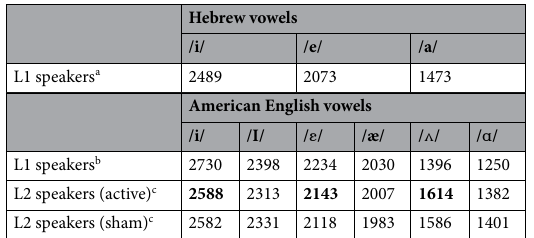
Table 2. Mean F2 frequency of the American English vowels included in the study and of similar vowels in Hebrew. Numbers in bold show a significant change following tDCS in the active stimulation group. a–b Values are from 74 and 73 , respectively, after multiplying male values by 1.172 and averaging across men and women for easier comparison with our values. c Values recorded